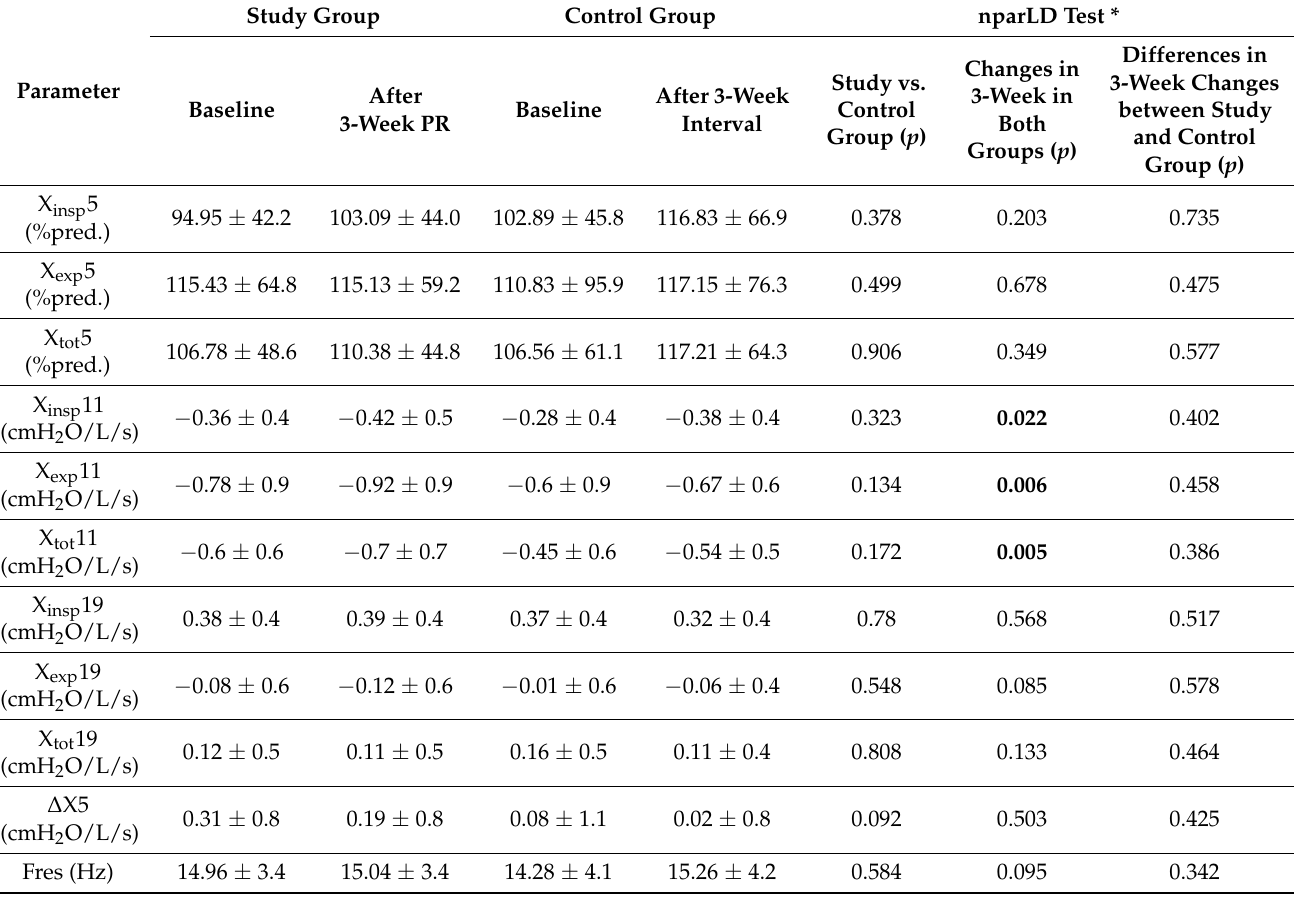
Table 4. Reactance (X), expiratory flow limitation ( ∆ X) and resonant frequency (Fres) at the baseline and after 3 weeks of pulmonary rehabilitation/interval.